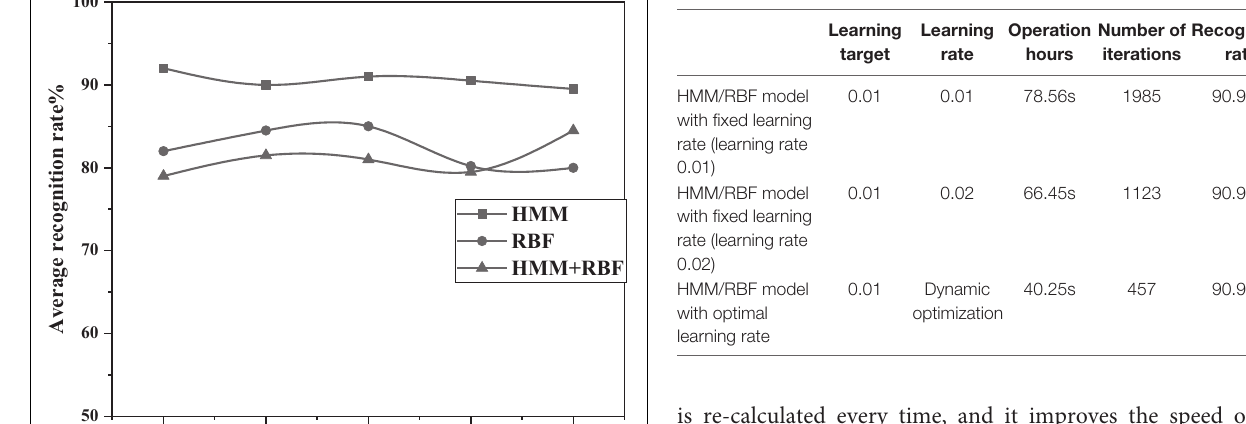
TABLE 4 | Convergence speed